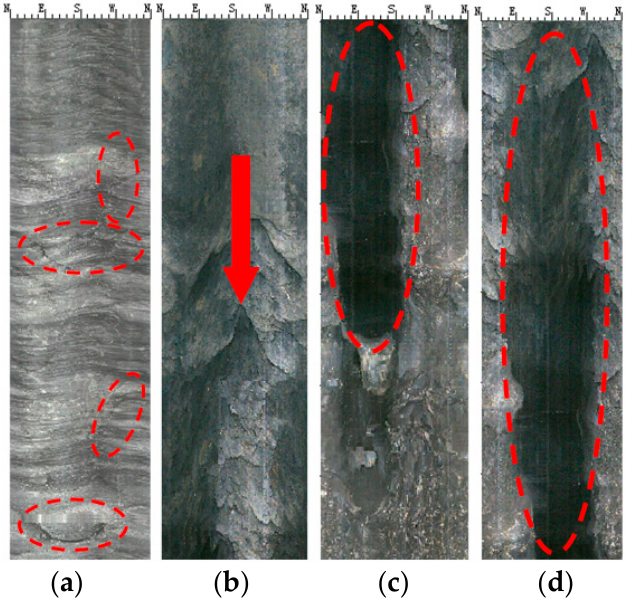
Figure 1. Expanded images of the borehole. ( a ) a few irregular fissures; ( b ) a transition area with more damage; ( c ) a small area borehole collapse and ( d ) a large area borehole collapse.